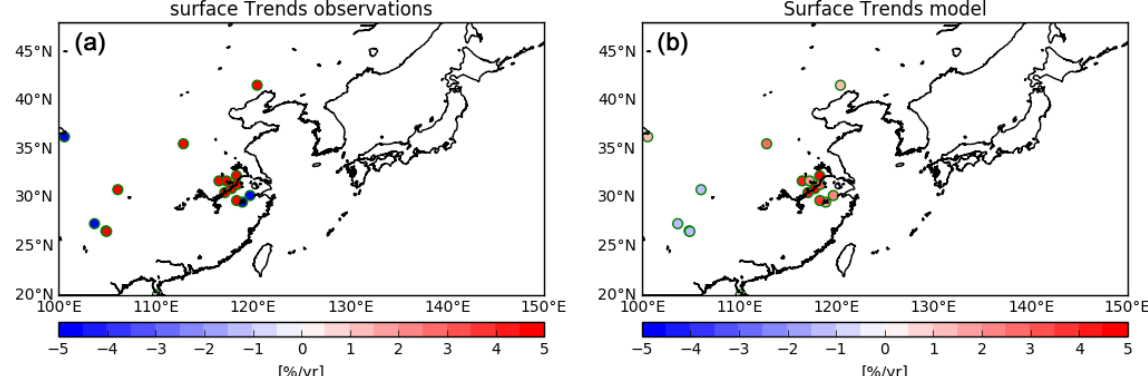
Figure A2. O 3 trends at the surface calculated from surface measurements (a) and simulations (b) for 2014–2017 at the location of rural stations described in Fig. A1. The trends is presented only when the p values are lower than